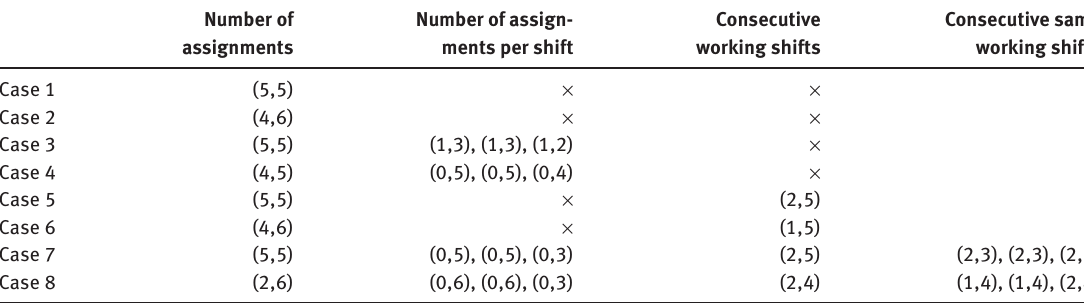
Table 3: Case-Specific